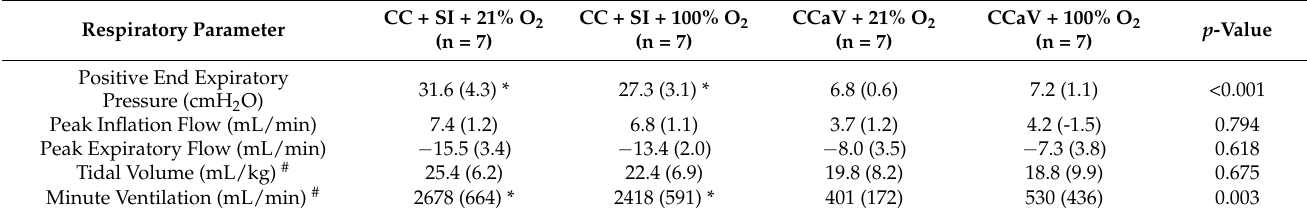
Table 4. Respiratory Parameters during the duration of Chest Compression.